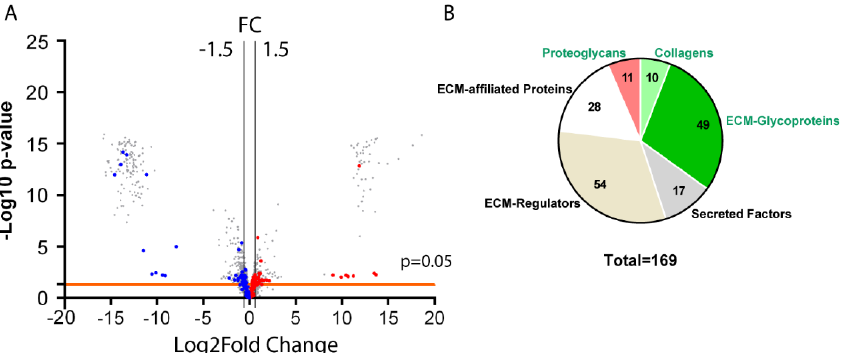
Figure 2. Total antrum matrisome in mice upon deletion of telocyte BMP-associated signaling. ( A ) Proteomic data from total antrum tissue isolated from control and BmpR1a △ FoxL1+ mice ( n = 4) were analyzed using ProStar to determine which proteins were significantly modulated. The volcano plot shows all differentially regulated proteins identified following mass spectrometry, highlighting sig- nificant matrisome proteins with at least a 1.5-fold change (plotted as log2FC) and a p -value lower than 0.05. Blue dots represent downregulated matrisome proteins; red dots represent upregulated matrisome proteins. The horizontal line represents the threshold p -value of 0.05. Vertical lines rep- resent the 1.5-fold change threshold (in log2). Volcano plot was generated using GraphPad Prism version 9.4.1. ( B ). Pie chart indicates the number of matrisome proteins identified in total antrum tissue according to categories (core matrisome proteins in green and matrisome-associated proteins in black).